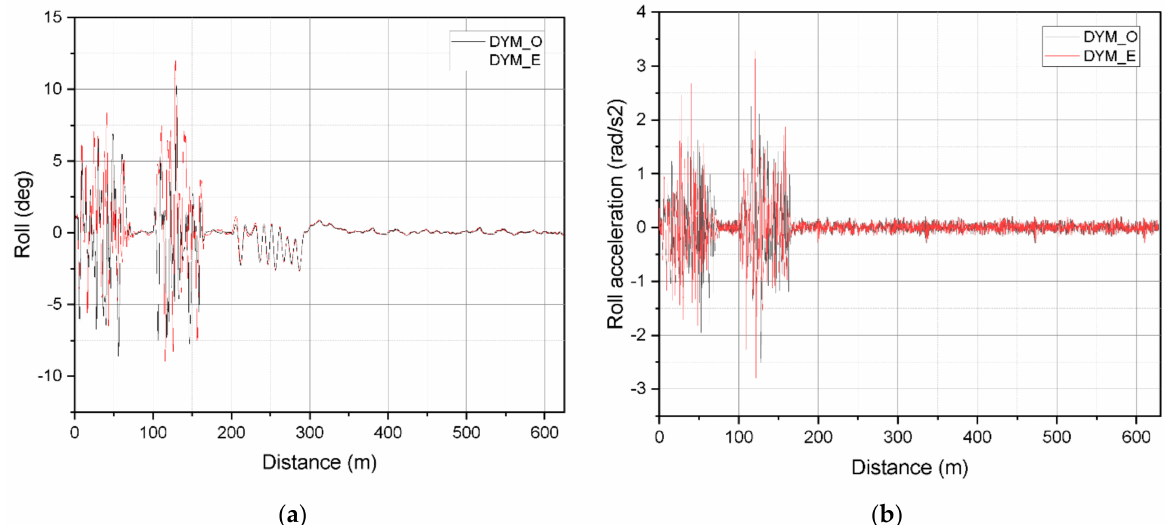
Figure 7. The comparison of roll status: ( a ) roll angle status; ( b ) roll acceleration status.